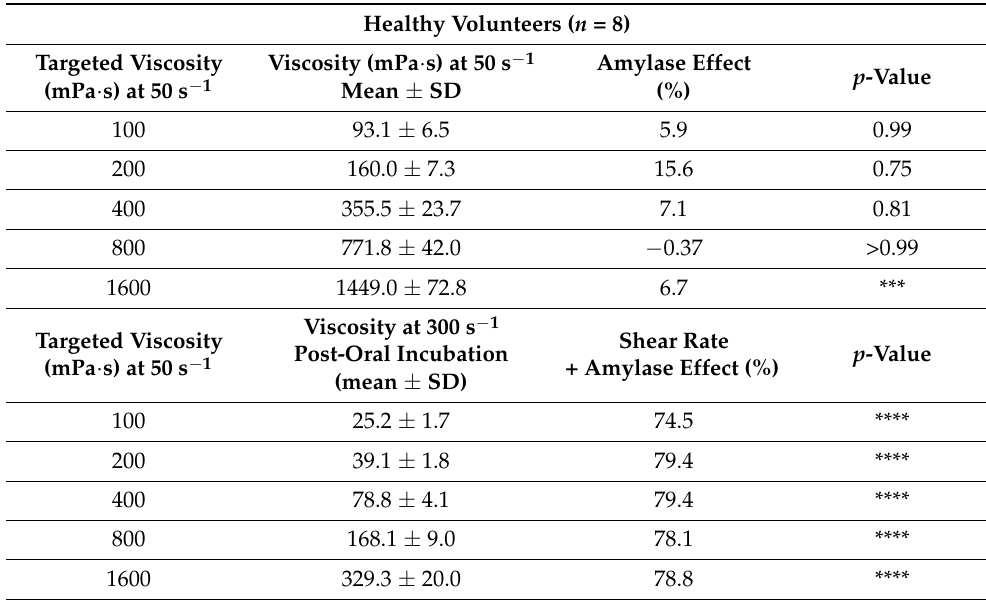
Table 5. Shear viscosity decrease caused by both swallowing factors (salivary amylase in the oral phase and shear thinning in the pharyngeal phase) in healthy